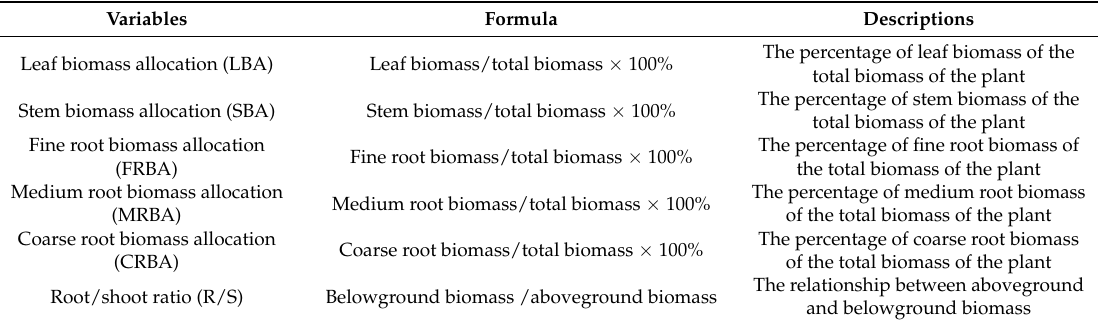
Table 1. Biomass variables used in analyses, together with formula and the descriptions.